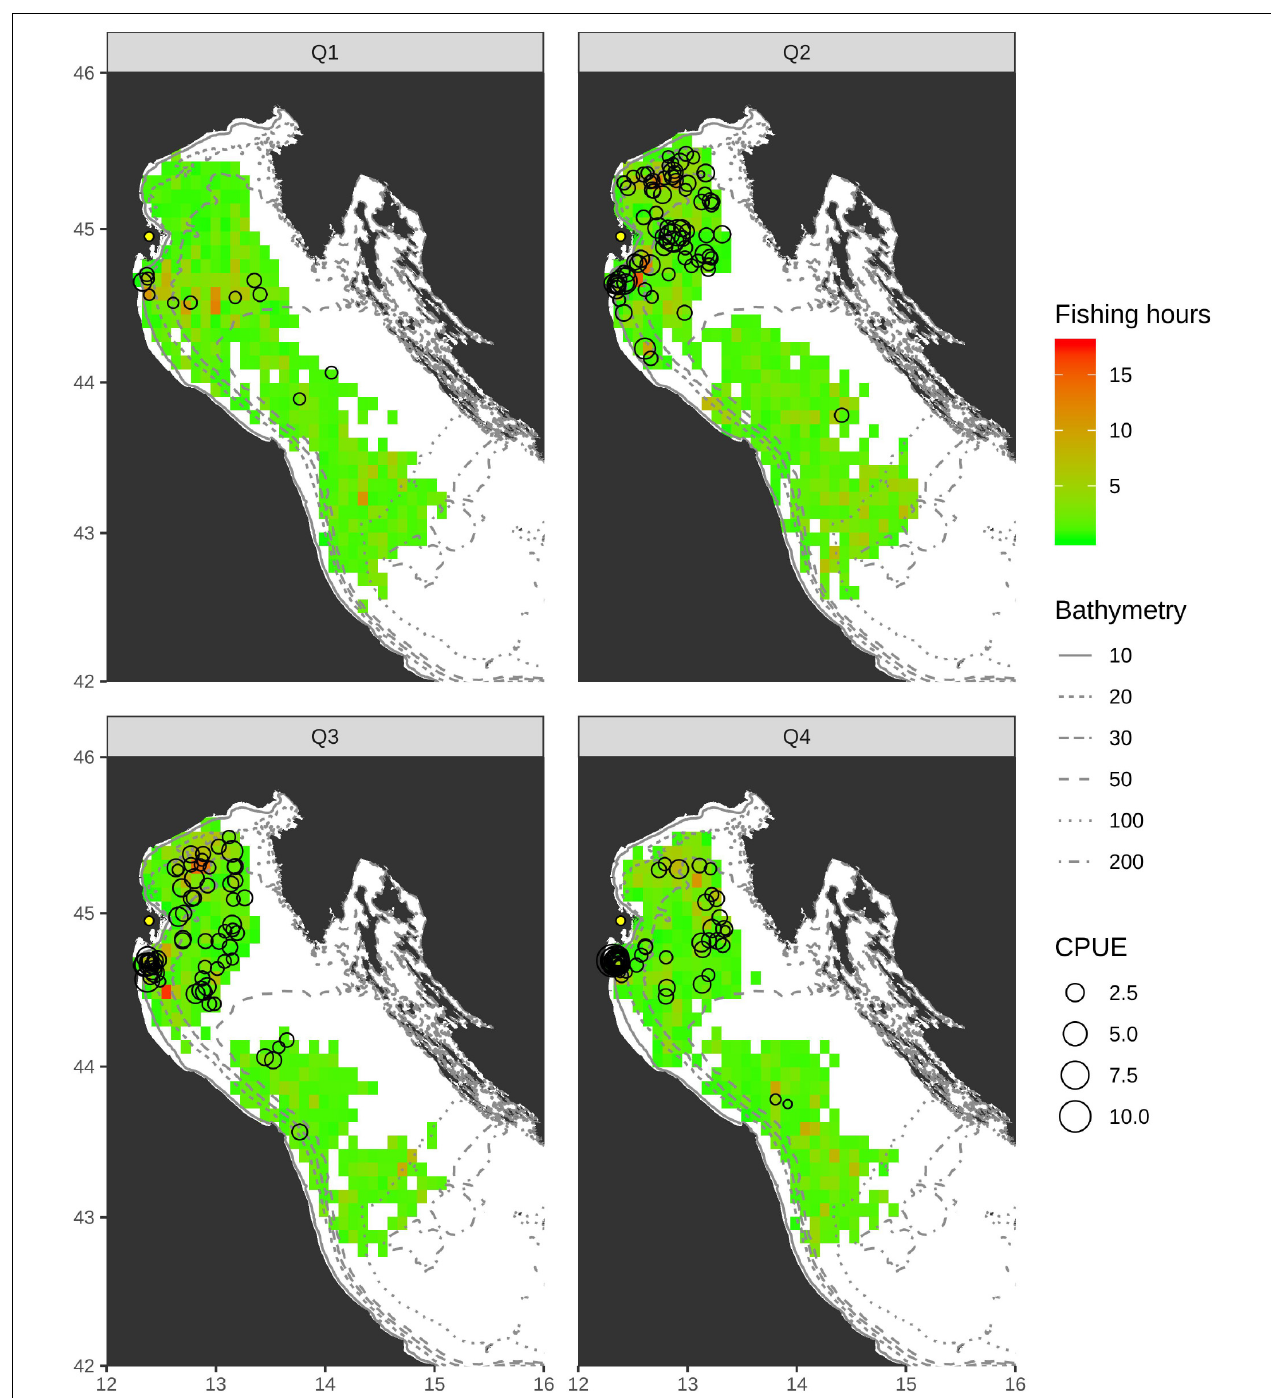
FIGURE 1 | Distribution of hauls and bycatch events of Caretta caretta collected between 2006 and 2018 aggregated at quarterly base using a spatial grid with cell of 0.09 ◦ (about 10 km). The intensity of fishing hours is showed with a color gradient from green (0–5) to red (10–15). The size of circles indicates the magnitude of bycatch events (CPUE). The River Po delta is illustrated with a red